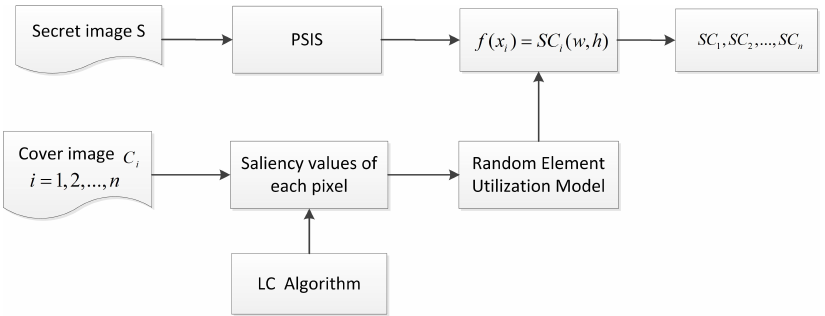
Figure 1. The main idea of Cheng et al.’s